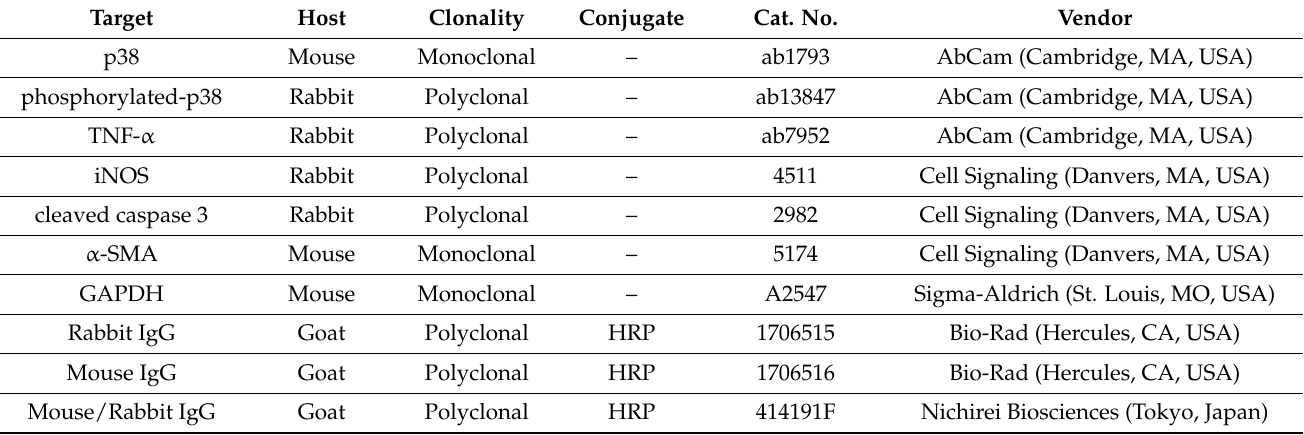
Table 4. Antibodies used in this